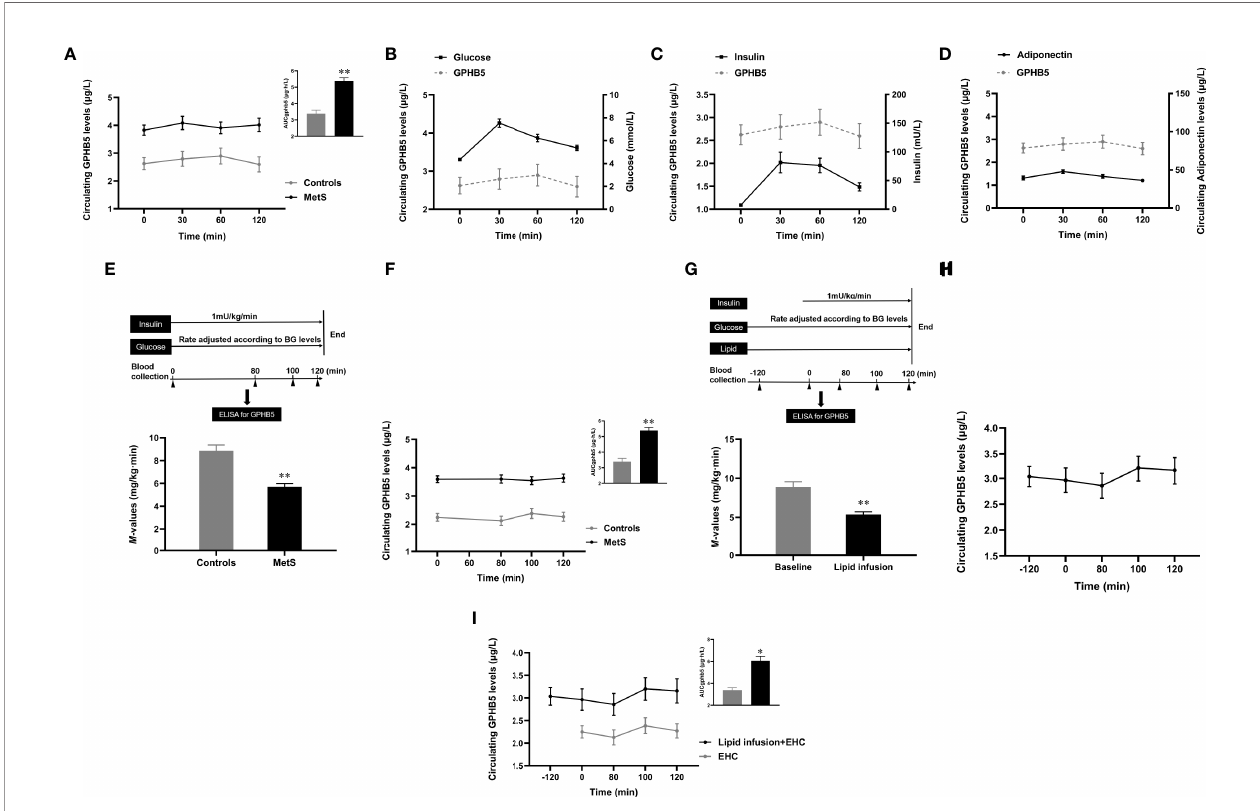
FIGURE 4 | Circulating GPHB5 levels in OGTT, EHC and lipid-infusion studies. (A) Circulating GPHB5 levels and AUC GPHB5 in healthy and MetS individuals during the OGTT. (B) Circulating GPHB5 levels and blood glucose in healthy individuals during the OGTT. (C) Circulating GPHB5 levels and insulin in healthy individuals during the OGTT. (D) Circulating GPHB5 levels and adiponectin in healthy individuals during the OGTT. (E) EHC experimental design and M-value in healthy and MetS subjects. (F) During the EHC, GPHB5 levels and AUC GPHB5 in MetS and control individuals. (G) Experimental design of lipid-infusion + EHC (upper) and M- values (bottom) in healthy women. (H) Time course of GPHB5 levels changes during lipid-infusion + EHC. (I) Time course of GPHB5 levels changes during the EHC alone or lipid-infusion + EHC. AUC, area under the curve; BG, blood glucose; Data are means ± SD. *p < 0.05 or **p < 0.01 vs.